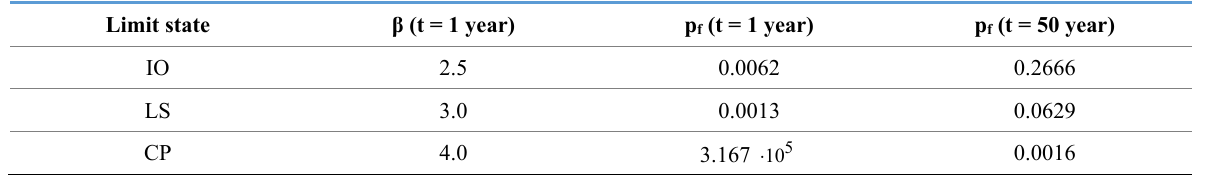
Table 3. Acceptance criteria in terms of annual failure probability (p f ) and rel iability index (β) for each limit state.